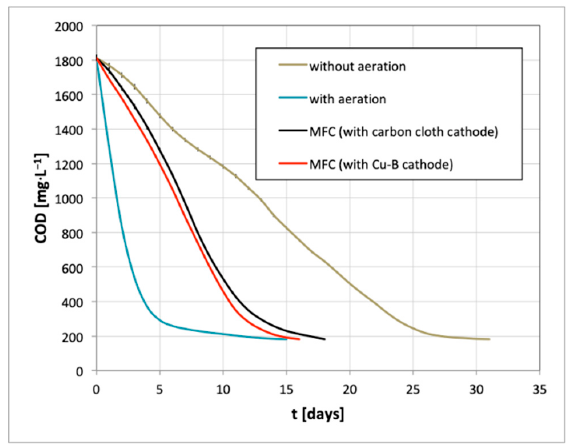
Figure 10. Trend of chemical oxygen demand (COD) reduction during wastewater treatment performed at the different reactors.